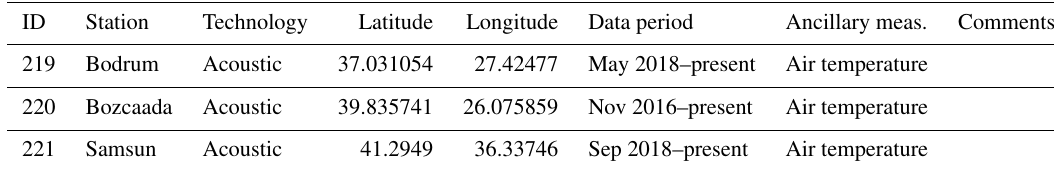
Table A22. JRC IDSL stations in Türkiye operated by